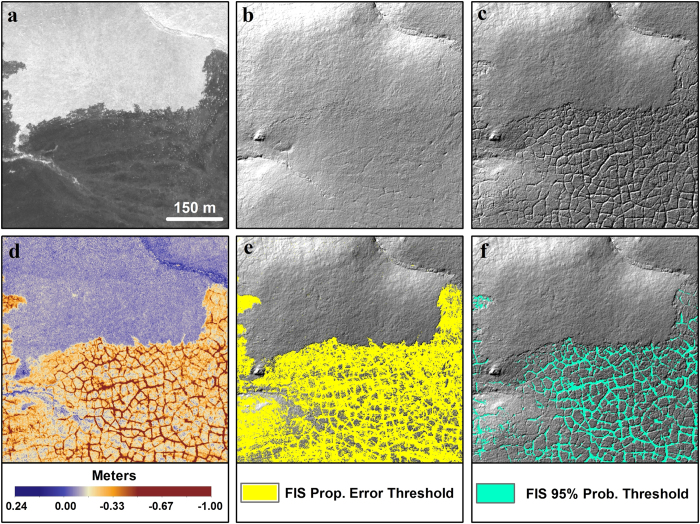
Detection of permafrost thaw subsidence and thermokarst initiation in burned tundra using multi-temporal LiDAR.(a) A Quickbird image from 05 July 2008, the year following the fire, showing a portion of the northern extent of the burn area and the distinction between burned (dark) and unburned (light) tundra. Hillshade images of the (b) 2009 and (c) 2014 1 m resolution LiDAR DTMs showing ice wedge degradation in the burn area. (d) The raw dDTM created by subtracting the 2009 DTM from the 2014 DTM. Detectable change determined using the (e) FIS propagation of errors threshold (>~0.2 m) and (f) the FIS 95% probability threshold (>~0.5 m)4553. These panels show the same area as shown in Fig. 3. Figure created in Esri® ArcMap™ 10.1.